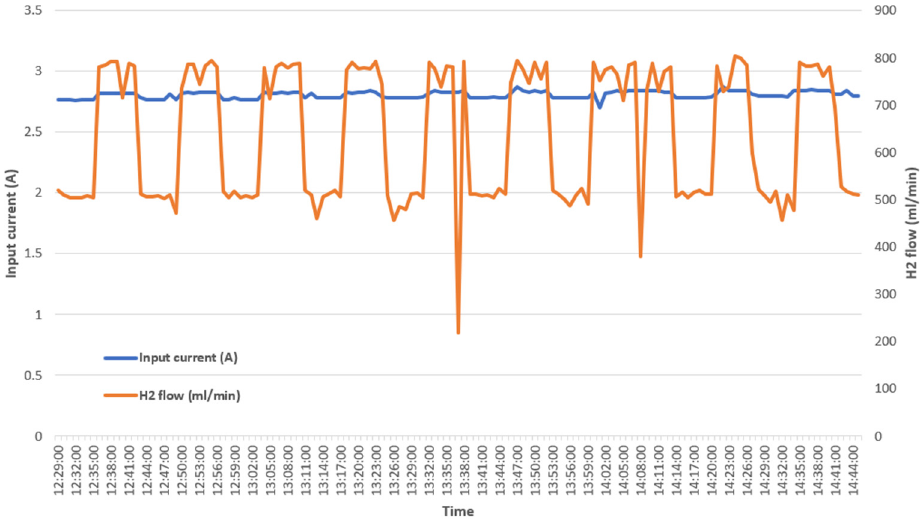
Figure 6. Input current and H 2 flow curve.